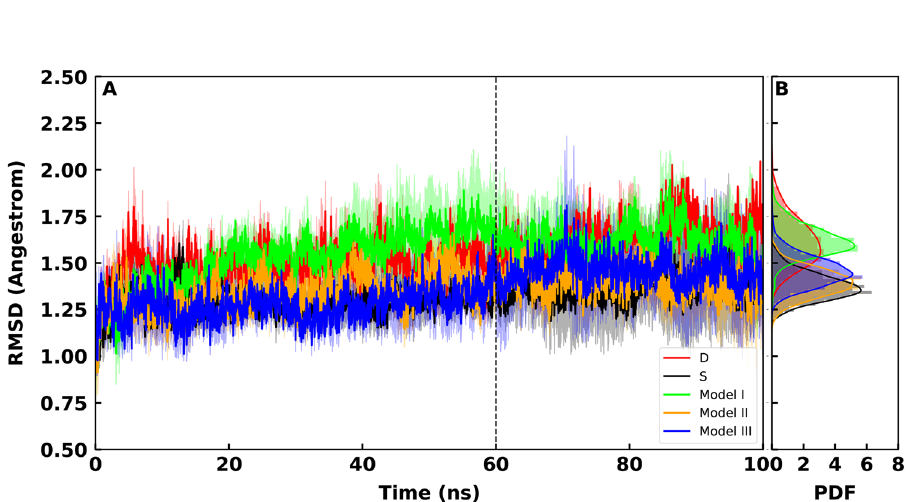
Figure 6. ( A ) Average backbone RMSD plots for Receptor binding RBD calculated from all replicates of each system and are shown for model model S (black), model I (lime), model II (orange) and model III (blue). Light shades around each plot presents standard error for each calculation. RMSD of model D is shown in red. ( B ) Probability Density Function (PDF) of RMSD sampled over the last 40 ns (dashed line) of the simulations are shown in